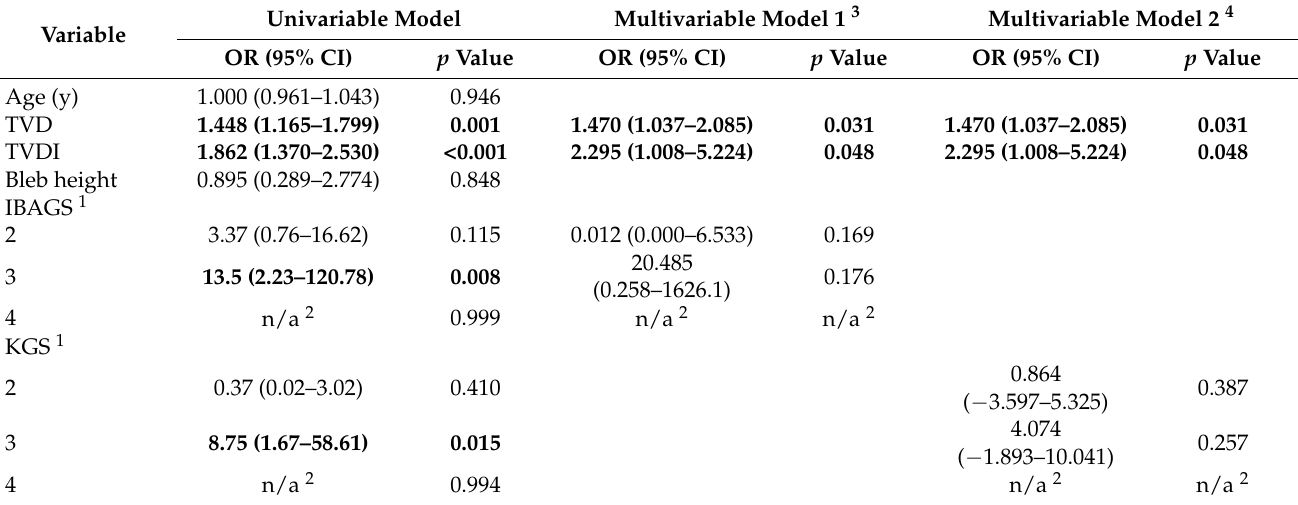
Table 5. Univariate and multivariate logistic regression analysis for surgical